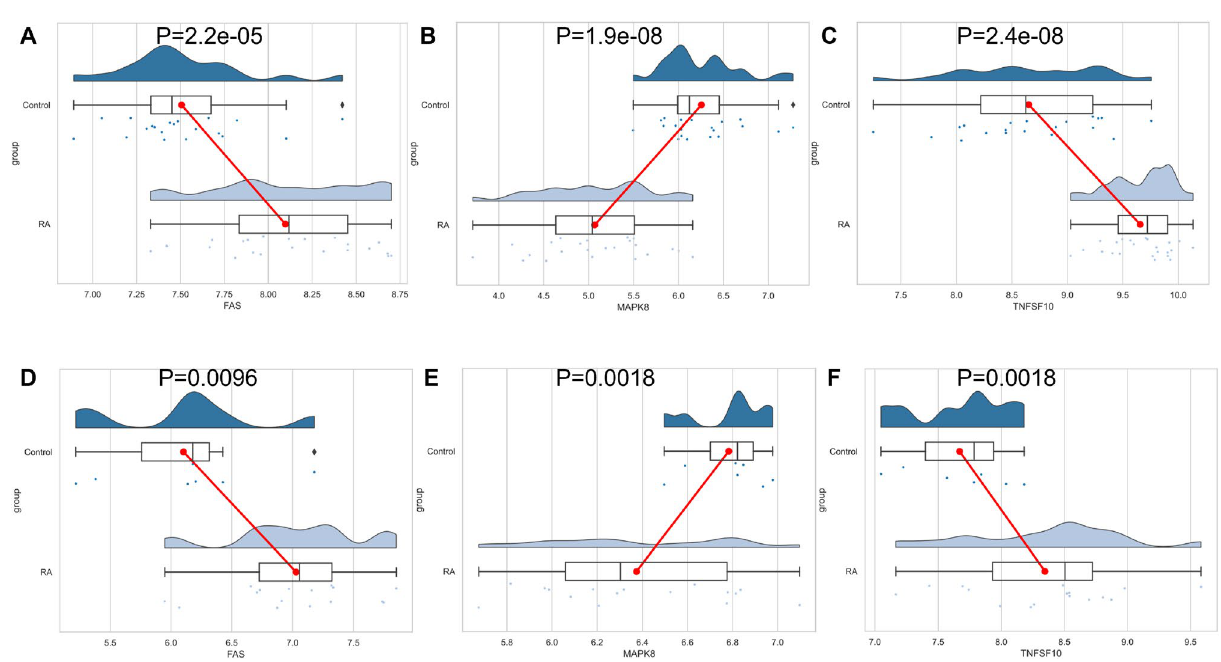
Figure 9. Key gene expression validation. ( A – C ) Expression of key genes in the training dataset. ( D – F ) Expression of key genes in the validation